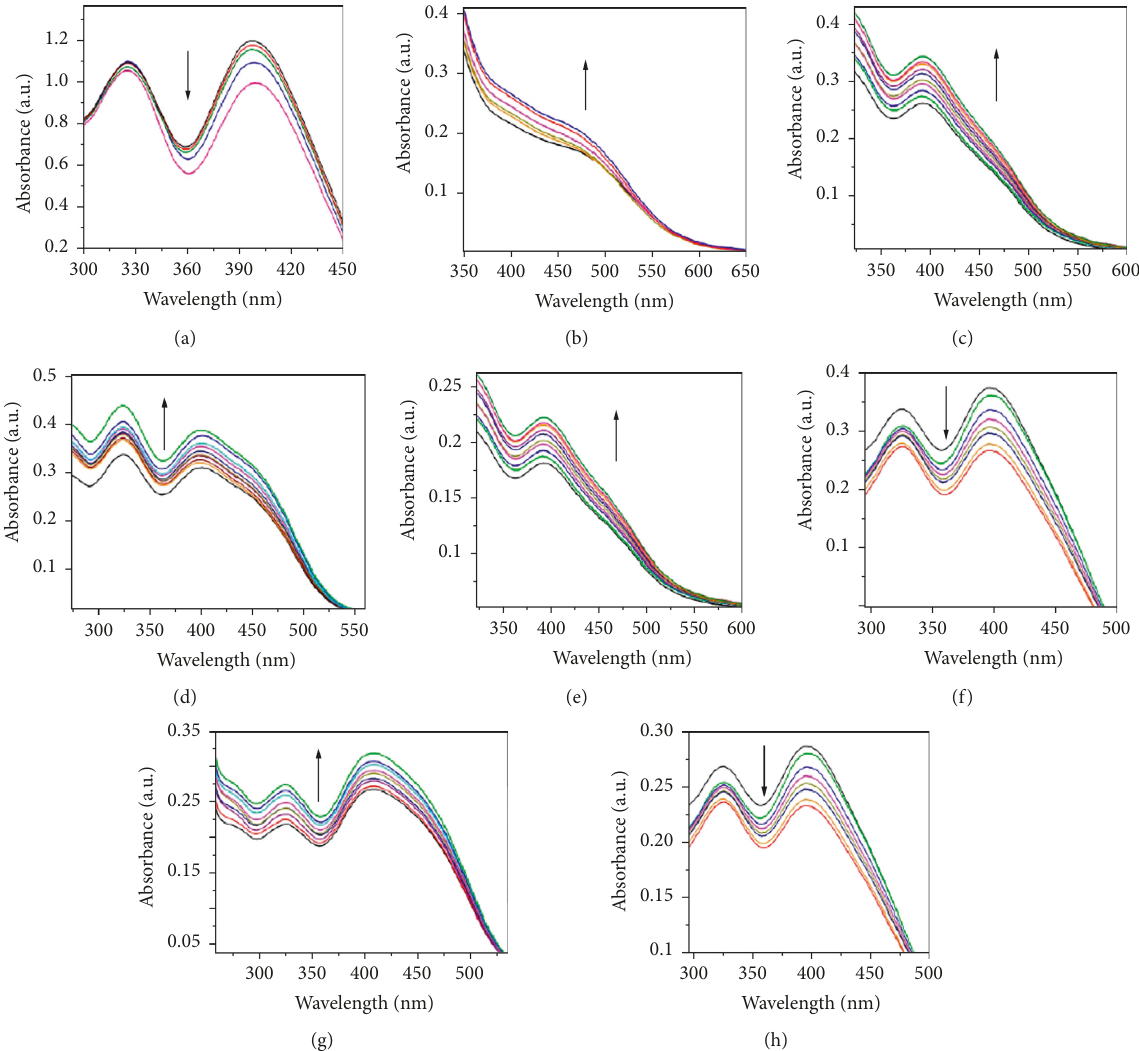
Figure 1: Absorption spectra of heterocyclic Schiff base derivatives 1 – 8 (a–h) upon the titration of salmon sperm DNA (SS-DNA). Arrow indicates the absorption change upon increasing the DNA